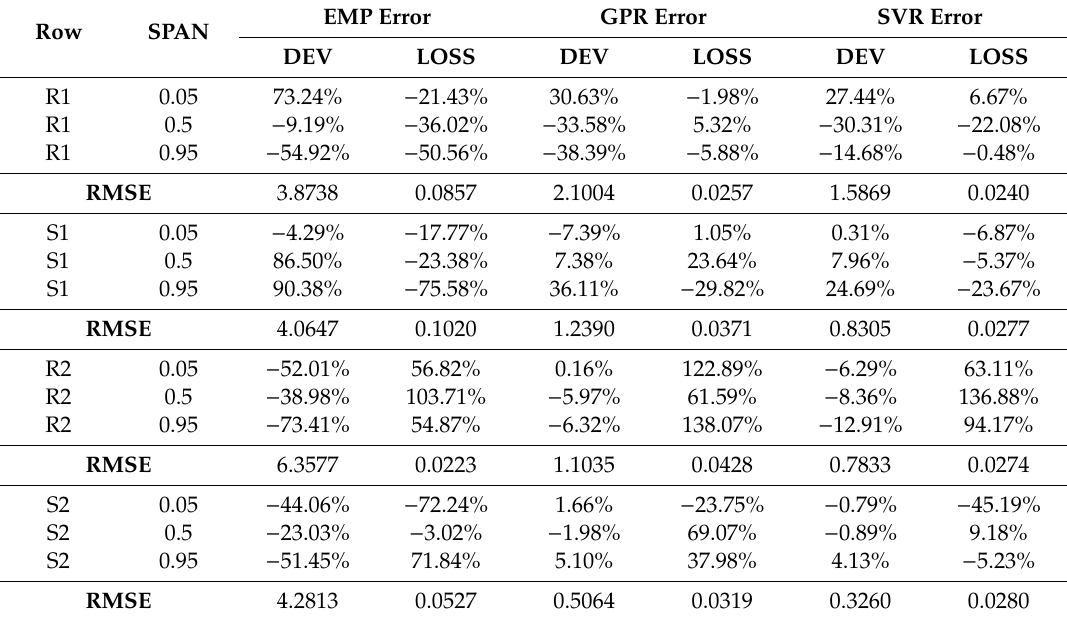
Table 7. Prediction errors at hub (0.05) middle (0.5) and tip (0.95) span location and